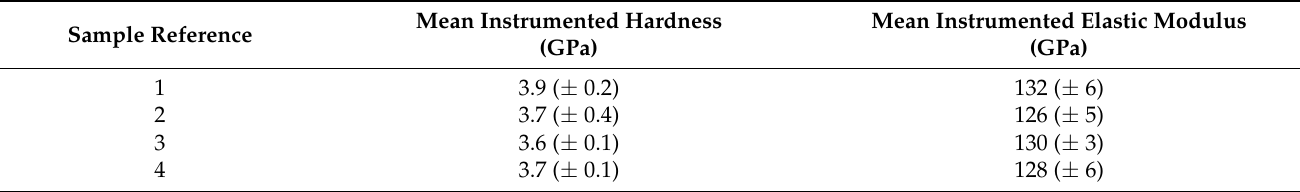
Table 5. Micro-indentation test